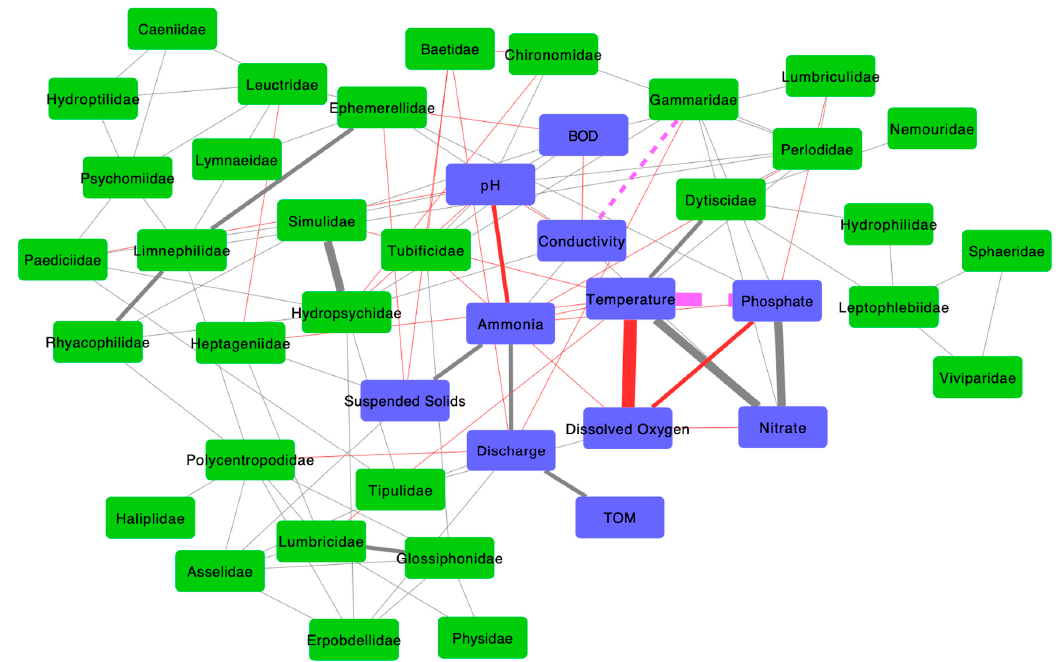
Figure 4. Visualised network of the Spearman’s rank correlation coefficients for sites 1 to 5 (a merged network). Each node represents a variable at the site, where blue nodes represent physicochemical variables and green nodes represent macroinvertebrate counts. The grey and red edges represent positive and negative interactions, respectively. Each edge represents a significant ( p < 0.05) correlation coefficient value between the variables, where ρ > 0.6. Edges that were found at more than one site have thicker lines.